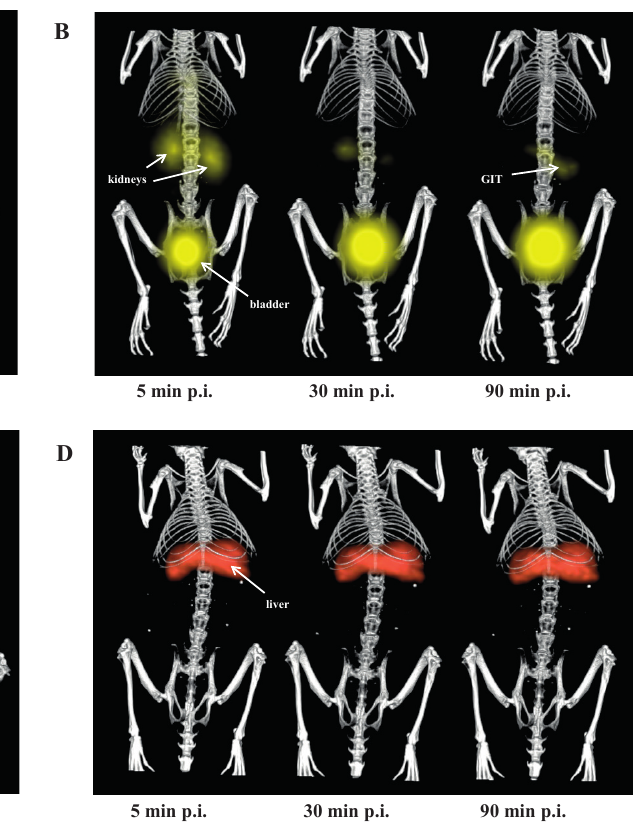
Fig. 4. Static μPET/CT imaging of 68 Ga-TAFC (A), 68 Ga- FOXE (B), 68 Ga-acetate/colloid (C), 68 Ga-colloid (D) and 68 Ga-citrate (E) 5 min, 30 min and 90 min p.i. (supine posi- tion; injected dose 5-10MBq; anaesthesia: 2% isoflurane; scan duration: 5-minute PET scan followed by 15-minute CT